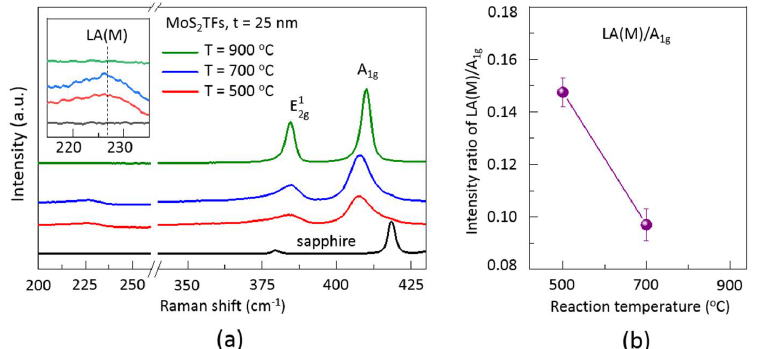
Figure 3. ( a ) Raman spectra of the 25 nm MoS 2 TFs on sapphire substrates as a function of the reaction temperature using 532 nm laser for sample excitation. The inset figure shows the Raman peak position of the LA(M) mode at 227 cm − 1 . ( b ) The LA(M) to A1g peak intensity ratio of MoS 2 TFs with different reaction temperatures. No clear LA(M) mode can be found in the Raman spectrum of the T = 900 °C MoS 2 TF sample (green color).